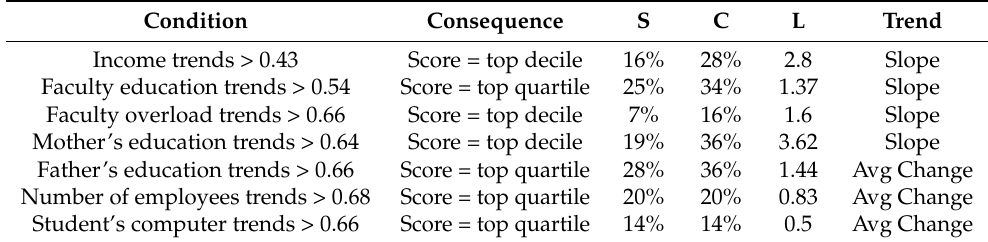
Table 4. Rules produced by OLAP queries to validate logistic regression findings. Condition